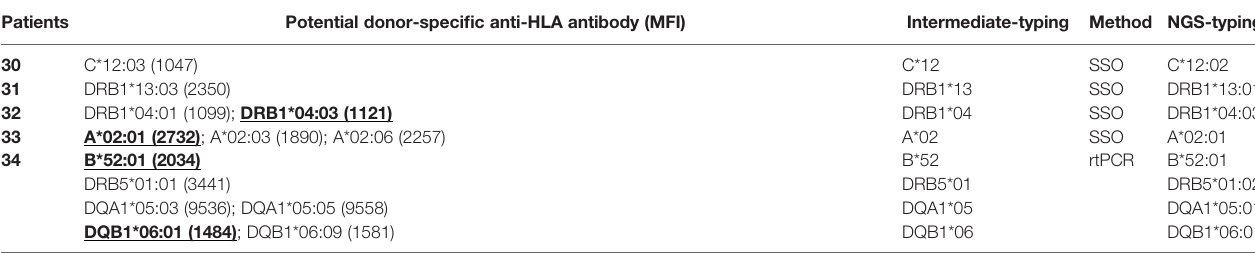
Table showing the kidney transplant recipients with reported donor-speci fi c anti-HLA antibody at time of transplantation, with corresponding intermediate resolution allele-speci fi c typing available at time of donor kidney allocation. Actual donor-speci fi c anti-HLA antibodies (bolded and underlined) are con fi rmed by high resolution donor HLA typing. Human leukocyte antigen (HLA); mean fl uorescent intensity (MFI); real-time polymerase chain reaction (rtPCR); sequence-speci fi c oligonucleotide